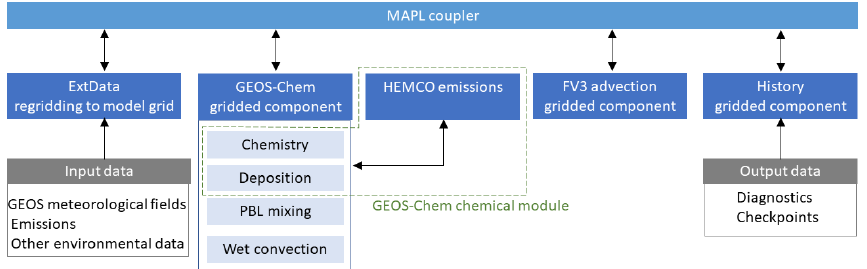
Figure 1. Schematic of GCHP architecture. The model consists of four gridded components (ExtData, GEOS-Chem, FV3, History) ex- changing information through the MAPL coupler. The HEMCO emissions module communicates directly with the GEOS-Chem gridded component in the current GCHP architecture, but it can also be used as a separate gridded component in other model architectures (Lin et al., 2021). The GEOS-Chem gridded component includes planetary boundary layer (PBL) mixing and wet convective transport of species as governed by the GEOS meteorological fields passed through MAPL. “Chemistry” also includes aerosol microphysical processes for which the continuity equations are analogous. The GEOS-Chem chemical module as defined in the text and illustrated here includes emissions, chemistry, and deposition and would be the unit passed to a meteorological model or ESM in online